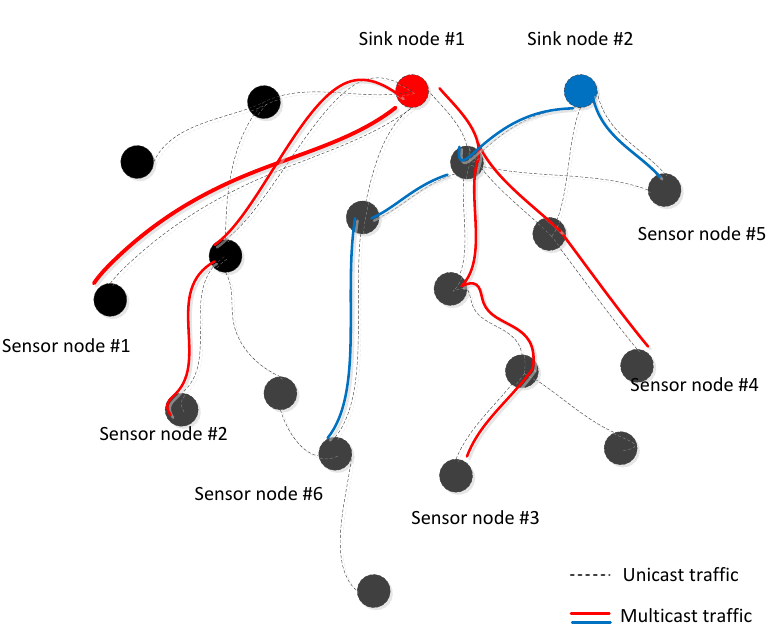
Figure 1. Scenario of unicast and